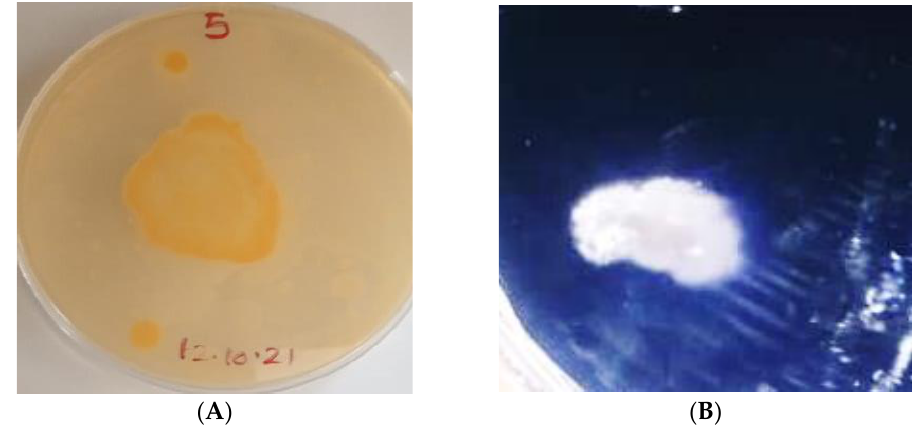
Figure 5. ( A ) Amylolytic potential; ( B ) Proteolytic potential of the isolated LAB strain NMCC-14. The appearance of white precipitates in the medium revealed that all selected strains produced BSH enzyme. NMCC-17 and NMCC-14 revealed a more prominent white zone in the medium, while, for NMCC-2 and NMCC-27, the white zones were not very prominent, indicating poor BSH enzyme production (Figure 6; Table 3).